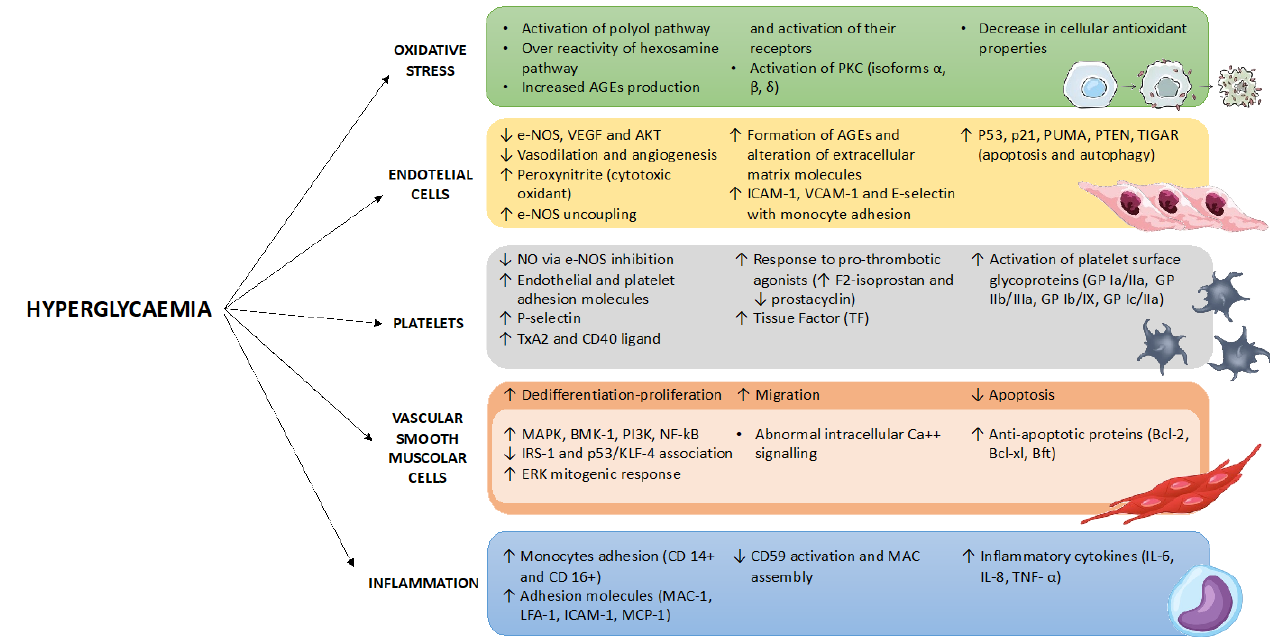
Figure 1. Pathophysiological mechanisms of hyperglycaemia-induced vascular damage. AGE, ad- vanced glycation end products; PKC, protein kinase C; e-NOS, endothelial nitric oxide synthase; VEGF, vascular endothelial grow factor; ICAM-1, intercellular adhesion molecule-1; VCAM-1, vascu- lar cell adhesion molecule-1; PUMA, p53 upregulated modulator of apoptosis; PTEN, phosphatase and TENsin homolog deleted on chromosome 10; TIGAR, TP53-Induced Glycolysis and Apoptosis Regulator; NO, nitric oxide; TxA2, Thromboxane A2; TF, tissue factor; GP, glycoprotein; MAPK, mitogen-activated protein kinase; BMK, big MAPK; PI3K, Phosphoinositide 3-kinases; NF-kB, nuclear factor kappa B; IRS-1, insulin receptor substrate 1; KLF-4, Kruppel Like Factor 4; ERK, extracellular signal-regulated kinase; BCL, B-cell lymphoma; Bft, Bacteroides fragilis toxin; MAC, membrane